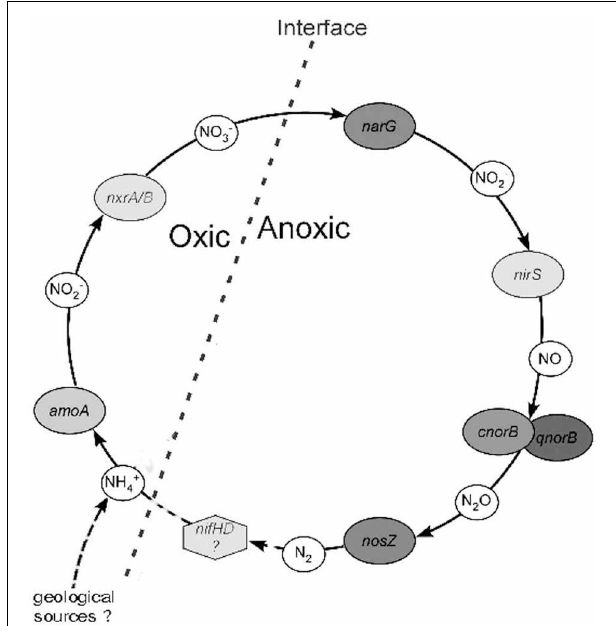
FIGURE 9 | Schematic representation of a proposed N-cycle in the FJQ spring. The oxic-anoxic interface is indicated by a bold broken line. Genes or gene fragments identified in this work are shown in oval frames. NH + 4 may derive from geological origins or via N 2 fixation ( nif genes), denoted by dashed